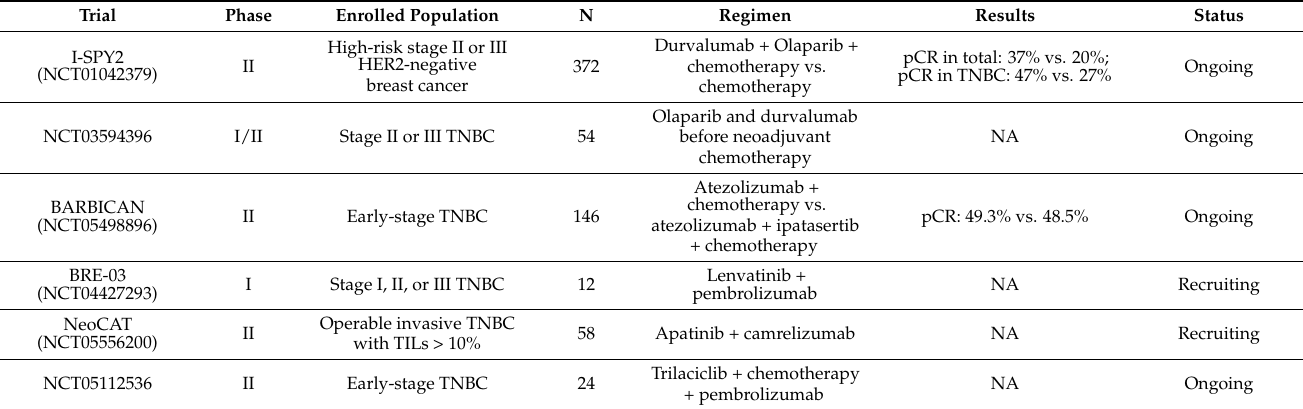
Table 3. PD-1/PD-L1 inhibitors plus targeted therapy trials in early-stage